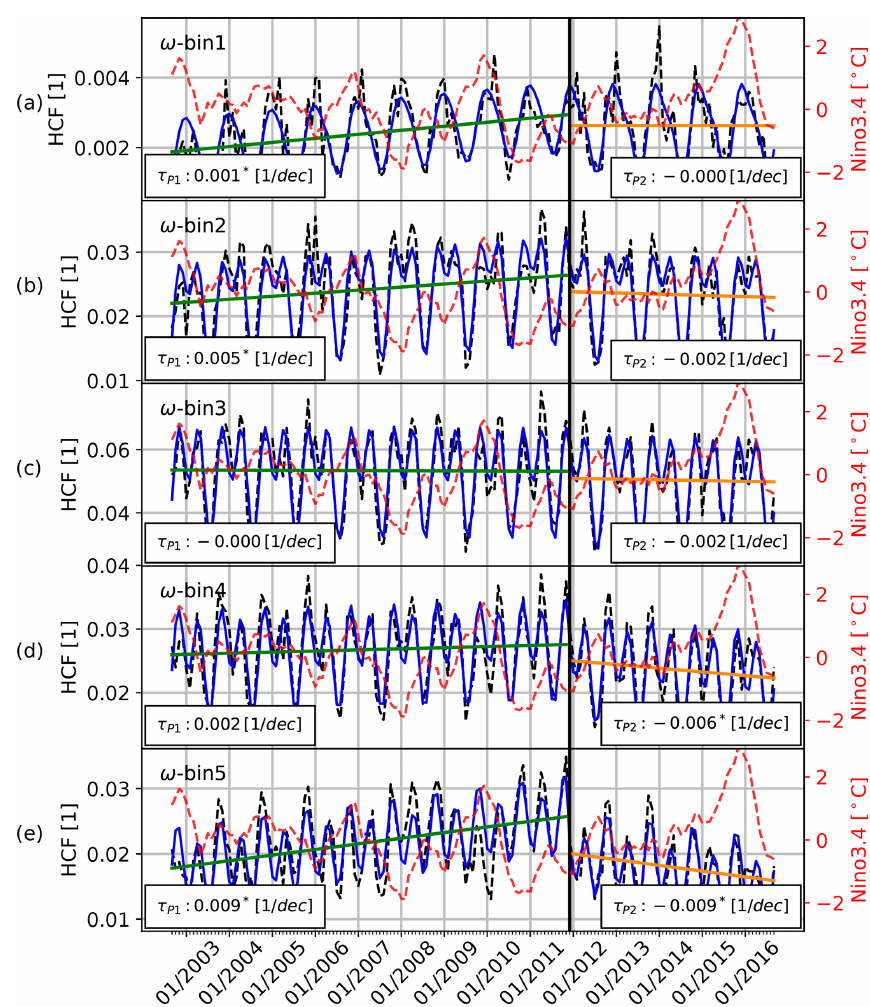
Figure 8. Time series of the tropical Atlantic domain-averaged HCF for different ω bins. (a) ω bin 1, (b) ω bin 2, (c) ω bin 3, (d) ω bin 4, and (e) ω bin